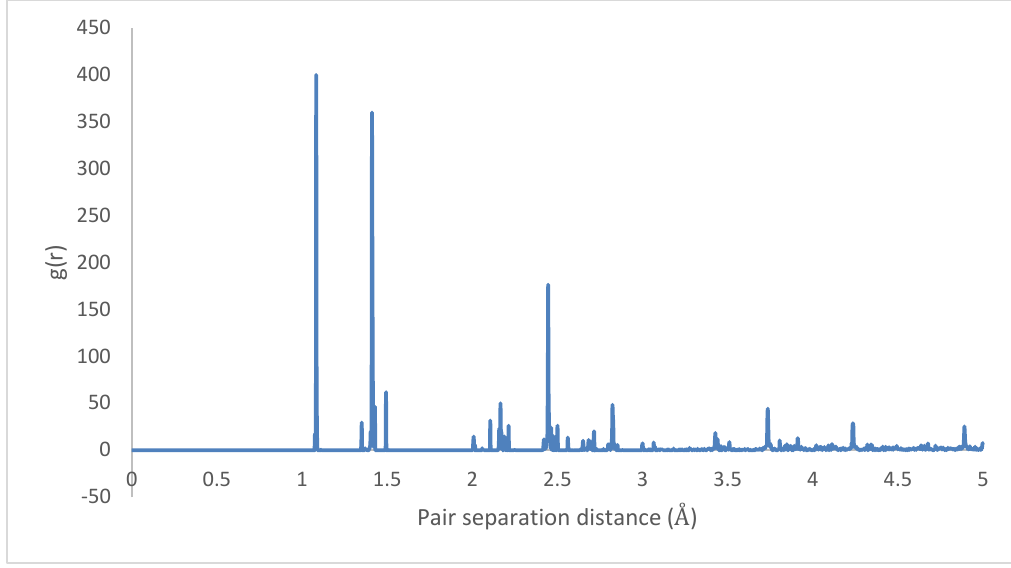
Figure 24. Radial distribution function: HB-4PPV–7 nm × 7 nm graphene (initial).